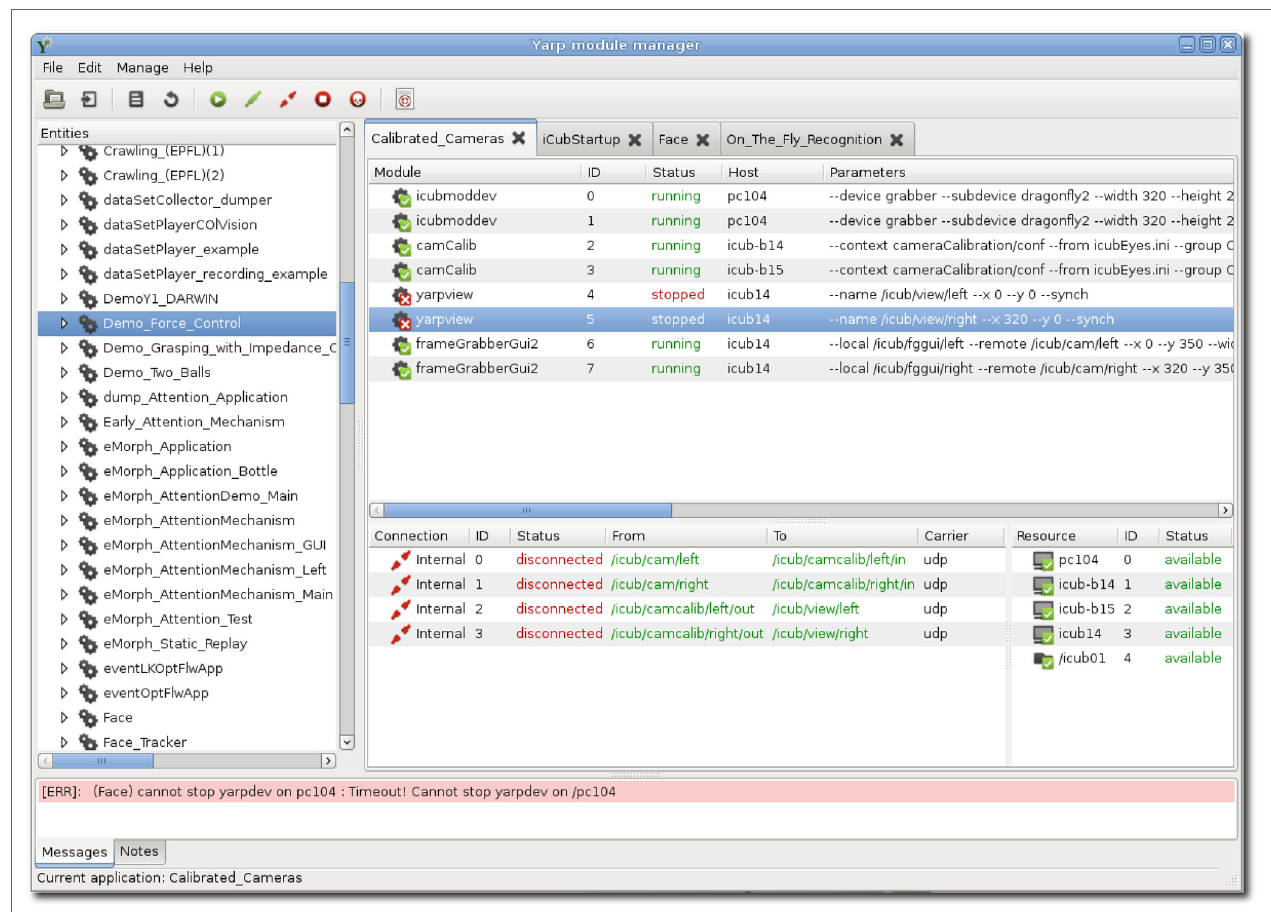
FigUre 11 | a screenshot of yarpmanager . On the left, the GUI shows the list of applications that are available and can be loaded. Each tab in the center window contains one of the four applications that have been loaded. For each application , the GUI shows the status of the components, the host in which it should be ran and the parameters. The bottom windows show the status of the Port and connections that are used by the current application . The bottom-right window shows the status of the nodes in the